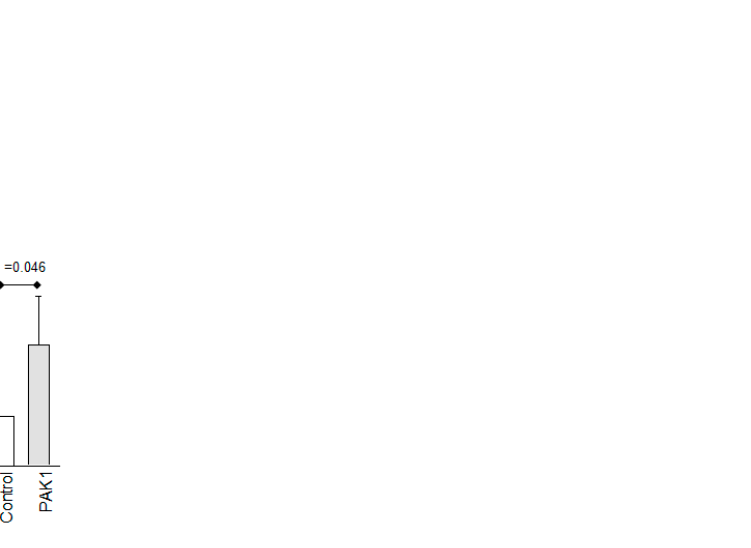
Figure 4. Effect of PAK1 overexpression on HIV-1 latency reversal in 24ST1NLESG cells. (a) Repre- sentative Western blot analysis of PAK1 overexpression; (b) quantification of PAK1 overexpression by Western blot using ImageJ; (c) effect of PAK1 overexpression on HIV-1 latency reversal mediated by TNF- α in 24ST1NLESG cells. Data are shown as the mean ± standard deviation from at least three independent biological replicates. Statistical significance evaluated using Mann–Whitney U test.